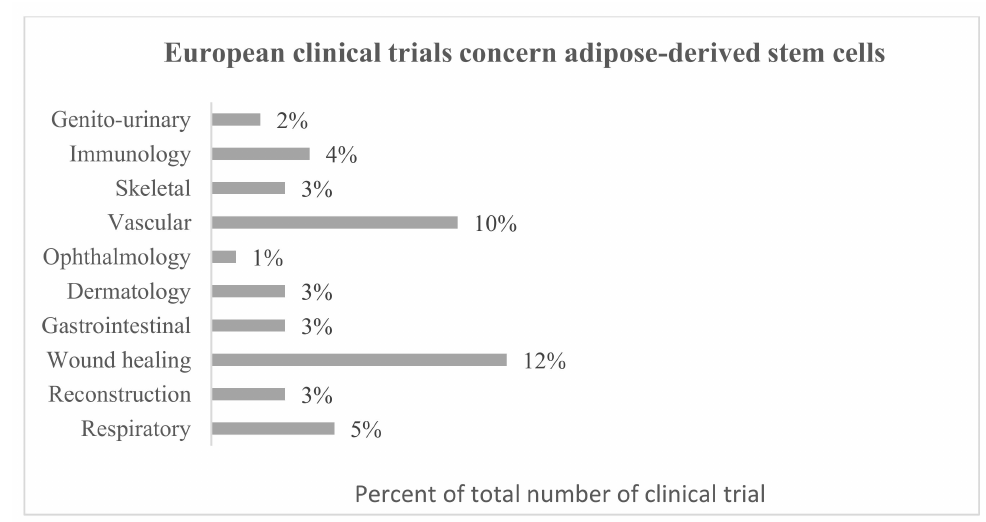
Figure 3. Summary of European clinical trials concern adipose-derived stem cells based on all clinical trials available in the database (years 2007–2021) [119].